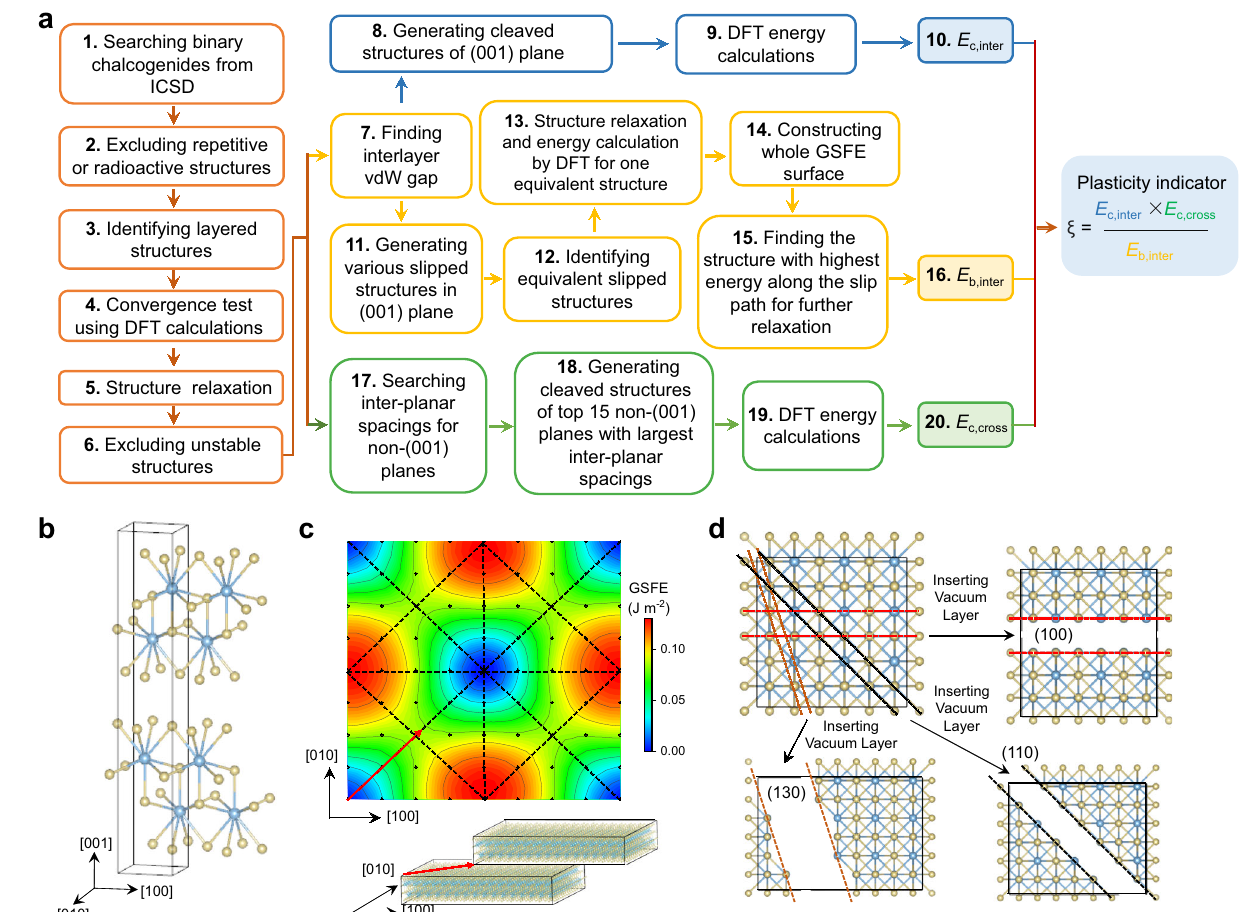
Fig. 1 |High-throughput methodology toscreen 2D vdWchalcogenidecrystals with plastic deformability. a High-throughput calculation fl ow. All the steps are automatized except for steps 6 and 15. b Crystal structure of CeTe 3 as a case example. c GSFEsurfaceof(001)plane(up)toanalyzetheinterlayerslip(down)for